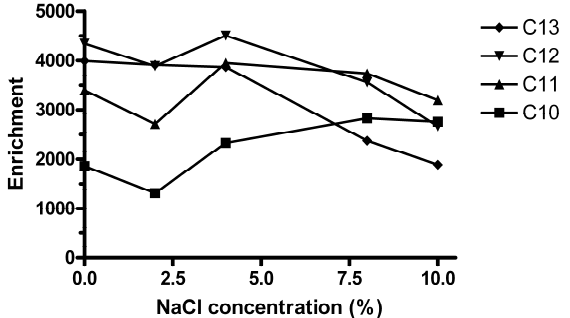
Figure 5. Effect of sodium chloride. Conditions as in Figure 1 ( n =